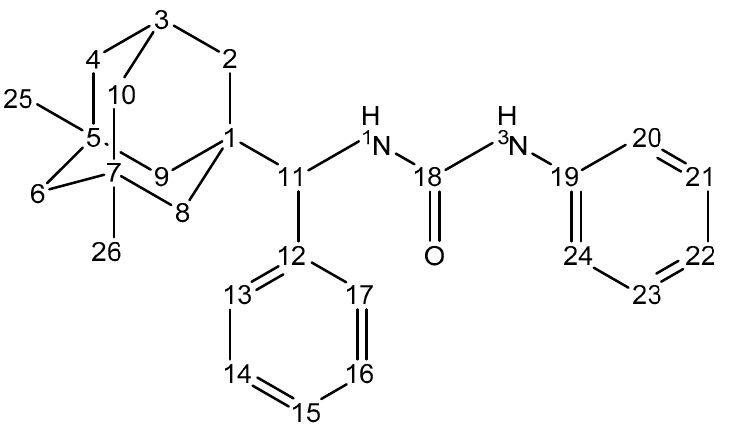
Figure 3. Carbon atoms labeled for compound 8f .